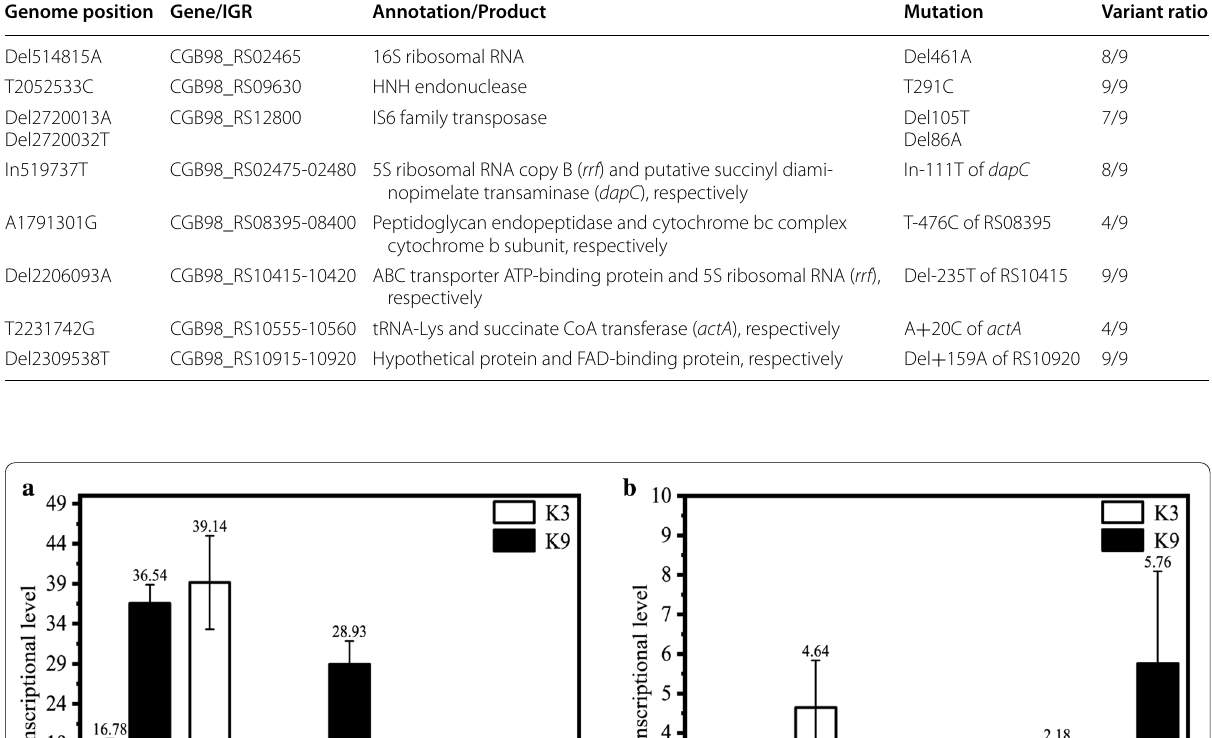
Table 3 Mutations discovered in evolved strains K1–K9 Genome position Gene/IGR